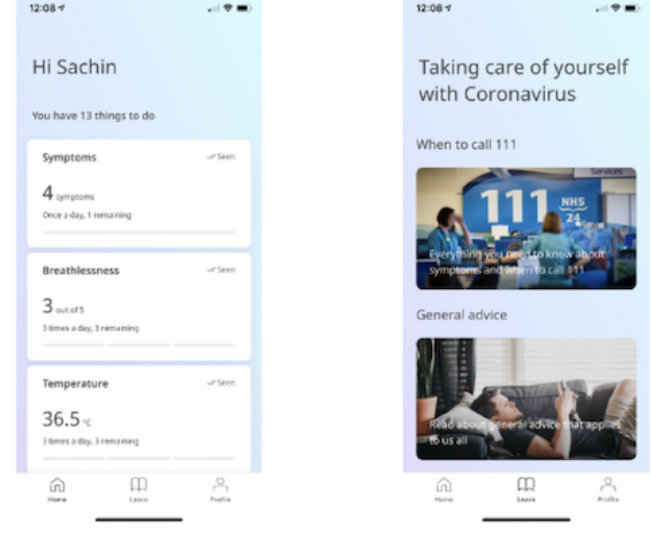
Figure 1. Screenshots of the mobile app (Huma Therapeutics) used by the study